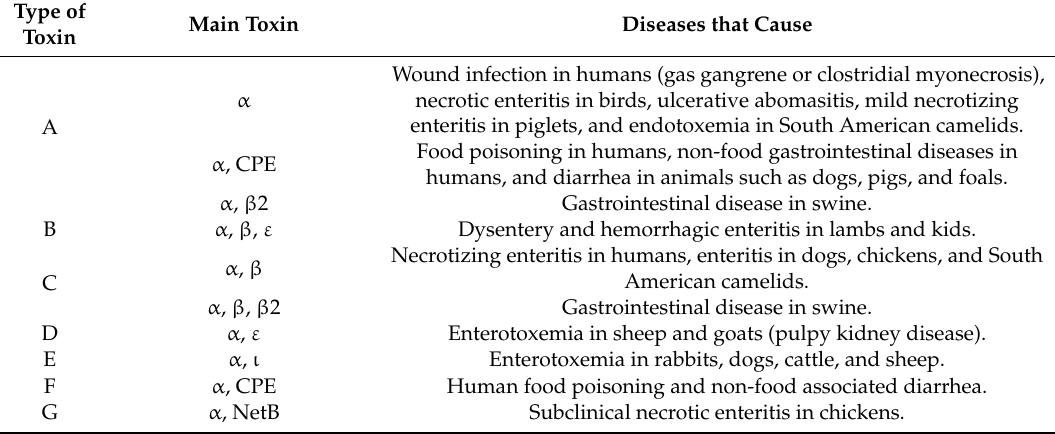
Table 2. Toxigenic types of Clostridium perfringens and their association with diseases in humans and